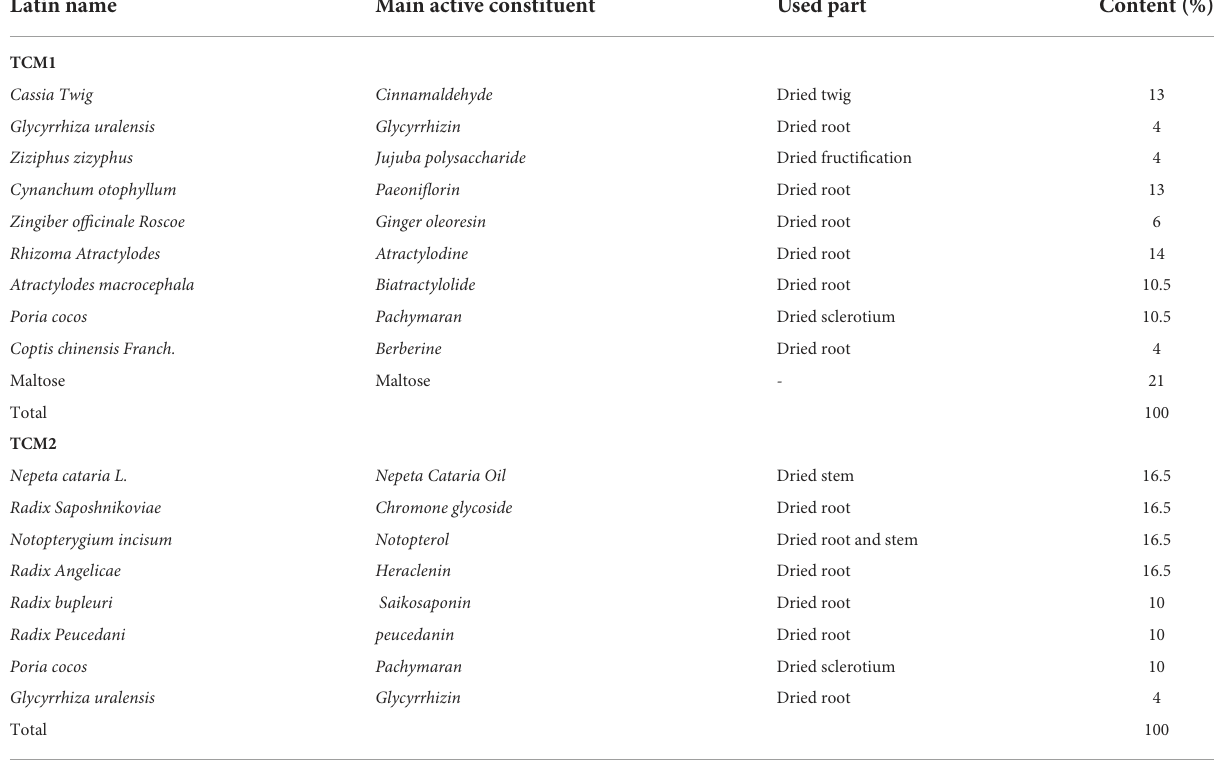
TABLE 2 Composition and main active constituents of TCM1 and TCM2 (air dry basis) a